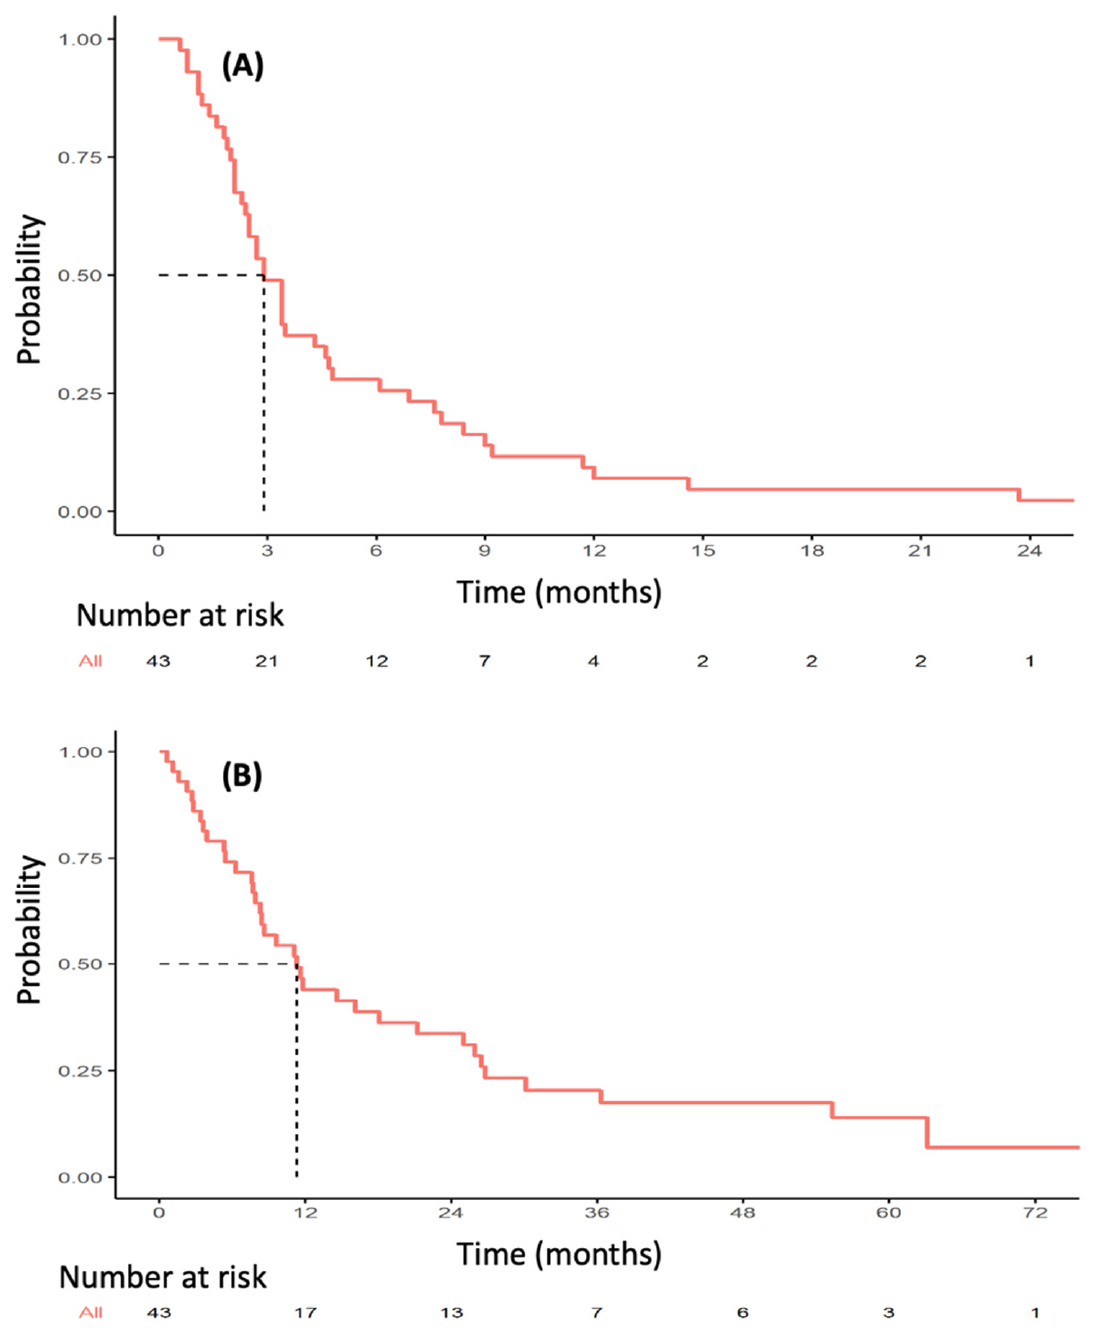
Figure 1. Kaplan–Meier estimates of progression-free survival ( A ) and overall survival ( B ) in patients treated with VP16 ‐ T.